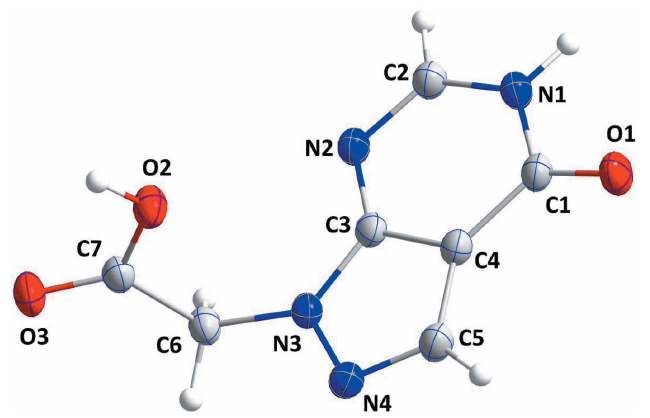
Figure 1 The title molecule with displacement ellipsoids at the 30% probability level.